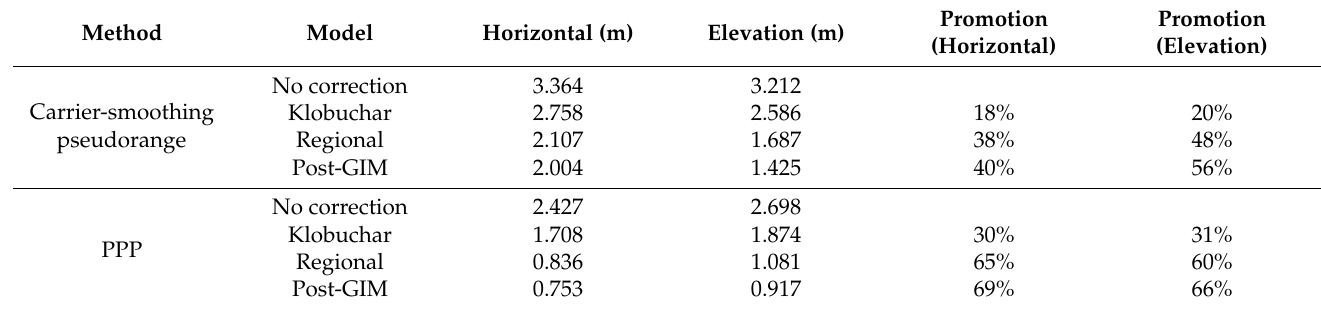
Figure 8. The positioning results of the Xiaomi 8 B smartphone. ( a ) Carrier-smoothing pseudorange positioning, ( b ) PPP (the no correction means no ionospheric correction). Table 3. RMSE of the positioning result.